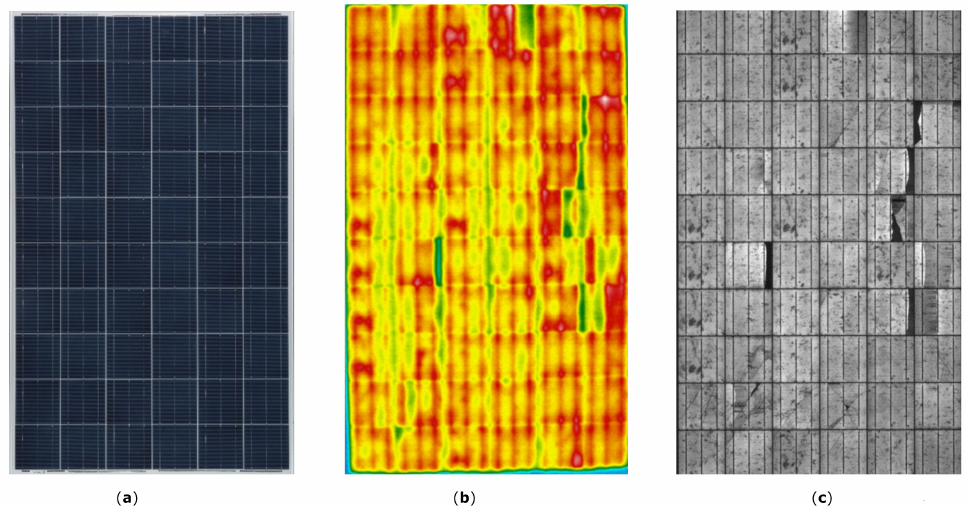
Figure 3. Different techniques for photography modules. ( a ) Visual spectrum; ( b ) thermography; ( c ) electro-